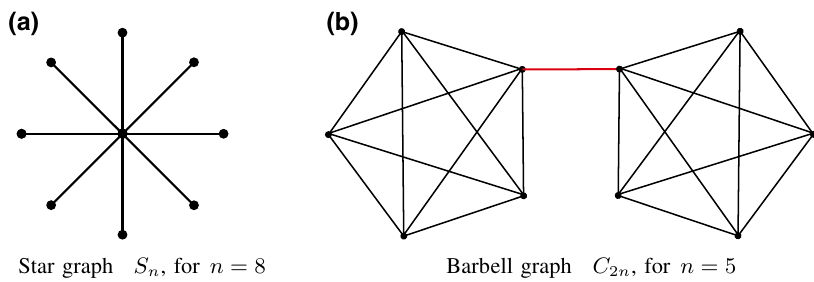
FIG. 4. Gate-based routing models cannot be separated up to a constant additive factor from classical routing on the star graph, but our lower bound on Hamiltonian routing is trivial in this case because of its (cid:2) ( 1 ) edge expansion. Classical and Hamiltonian routing cannot be separated on the barbell graph because of its O ( 1 / n ) edge